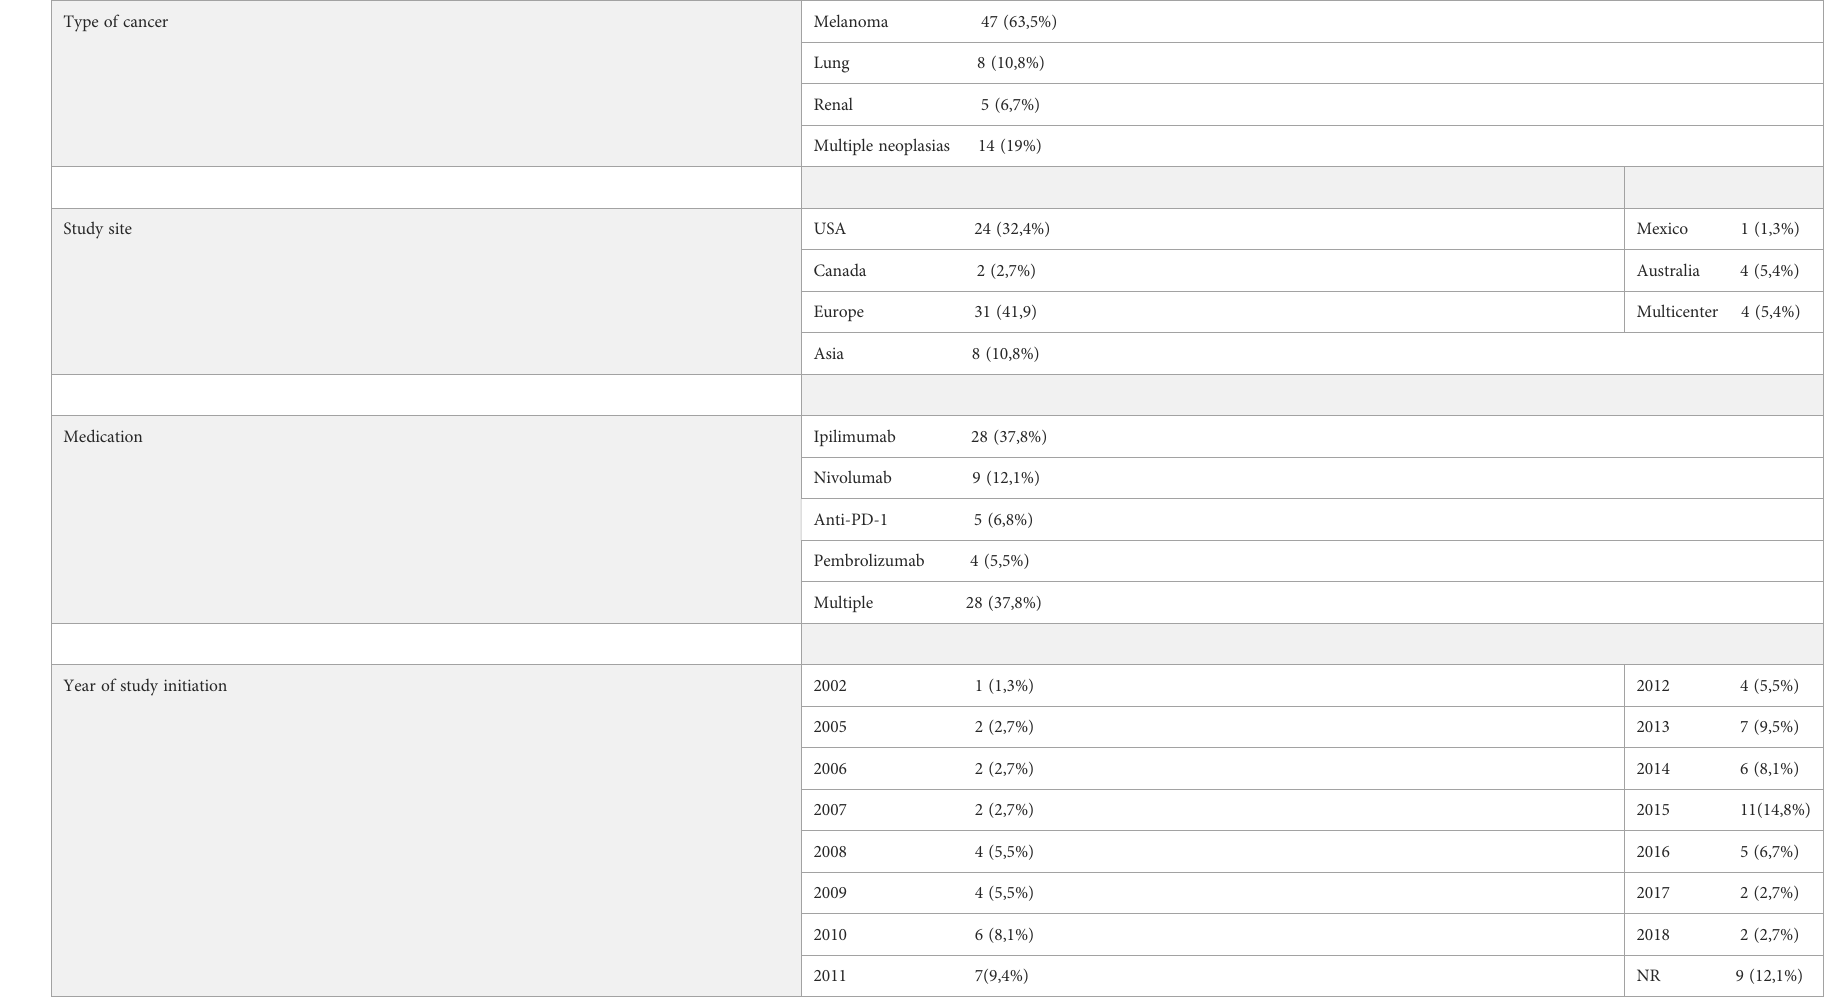
TABLE 1 Distribution of cohort studies according to the type of cancer studied, place of study, medication used and year of study